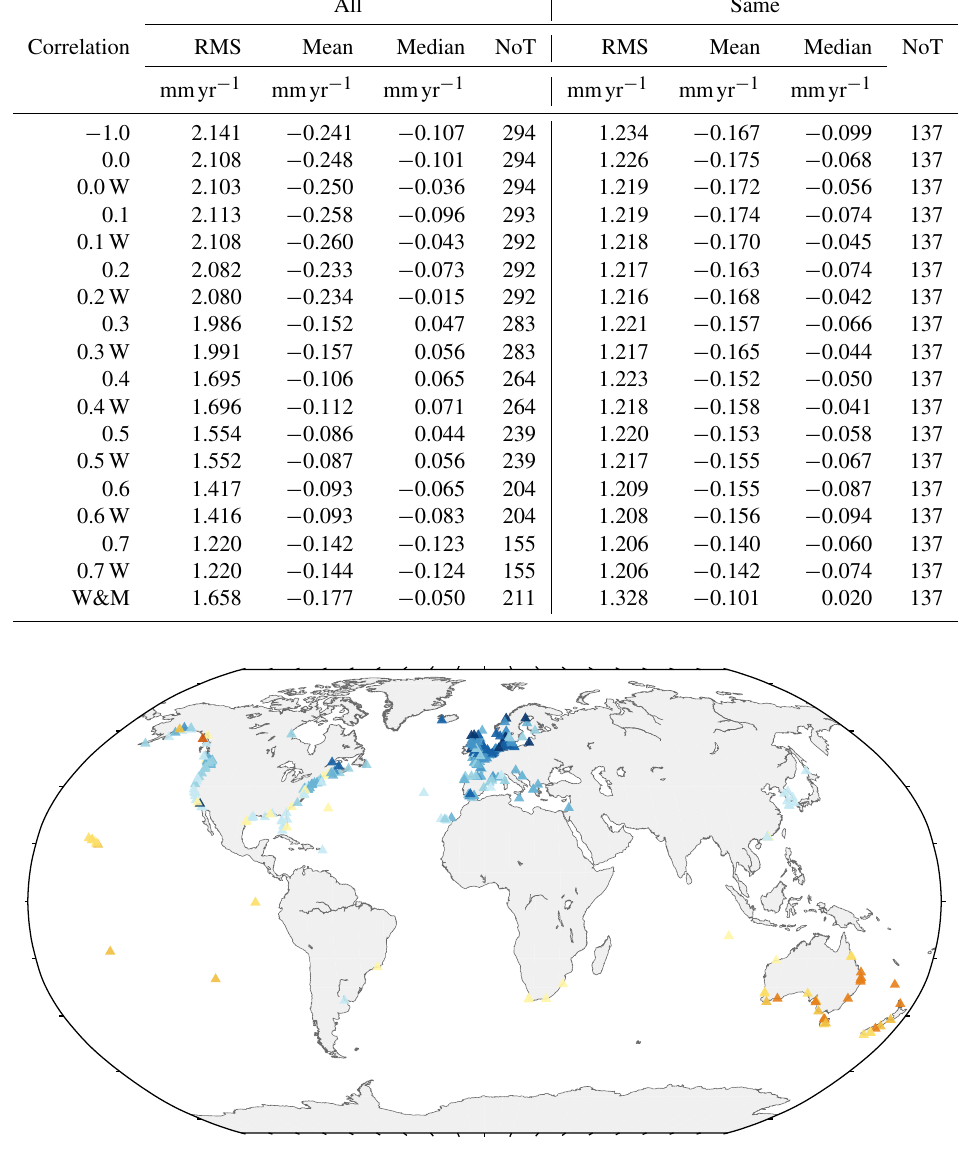
Table 4. Statistics of the differences between the median of the GNSS trends (approach 2) and the ALT–TG trends for various correlation thresholds. The “W” indicates that the altimetry time series are weighted by the correlation. The row “W&M” shows the comparison with Wöppelmann and Marcos (2016) trends. The column “NoT” indicates the number of TGs for which trend estimates are computed. On the left side of the table all stations are taken into account, and on the right side only stations are taken into account for which a solution exists for all correlation thresholds (including those from W&M).